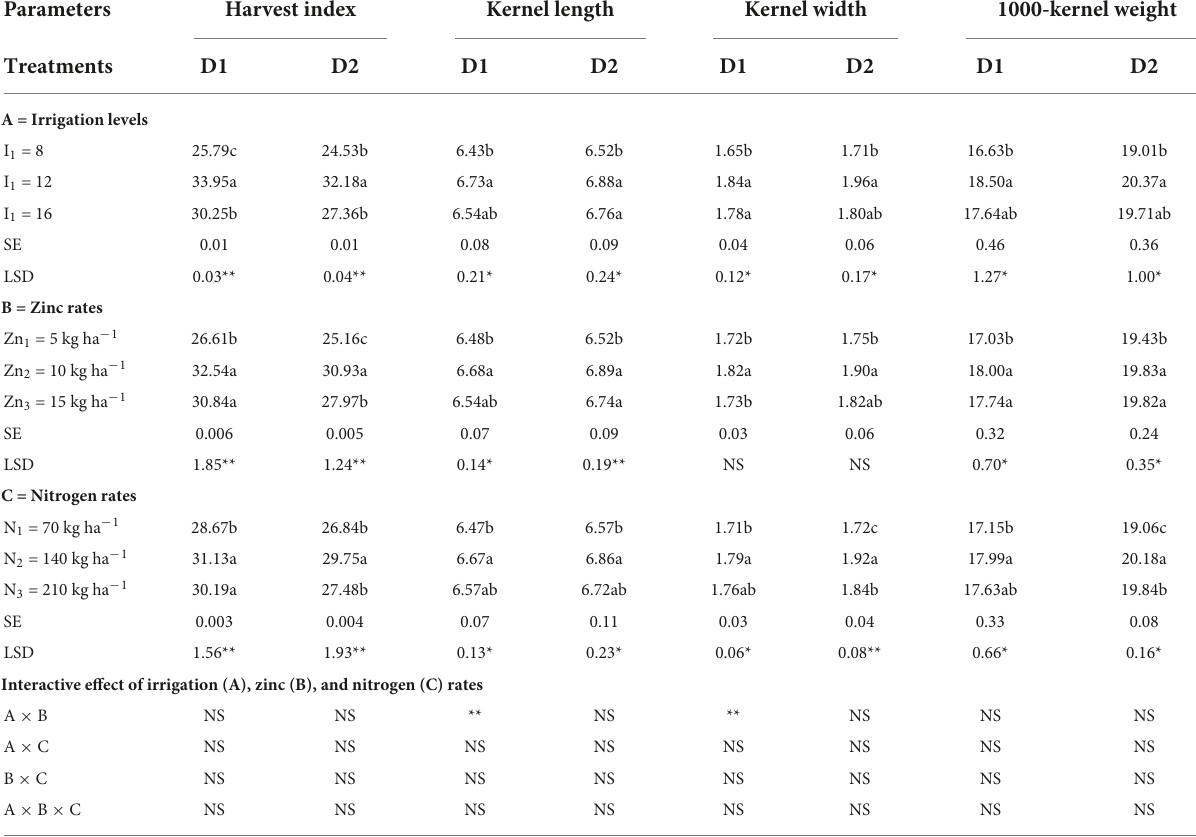
TABLE 3 Impact of zinc and nitrogen rates on harvest index, kernel length, and width, and 1,000-kernel weight of rice cultivated under three irrigation levels at Sheikhupura (D1) and Sargodha (D2) districts of Pakistan. Parameters Harvest